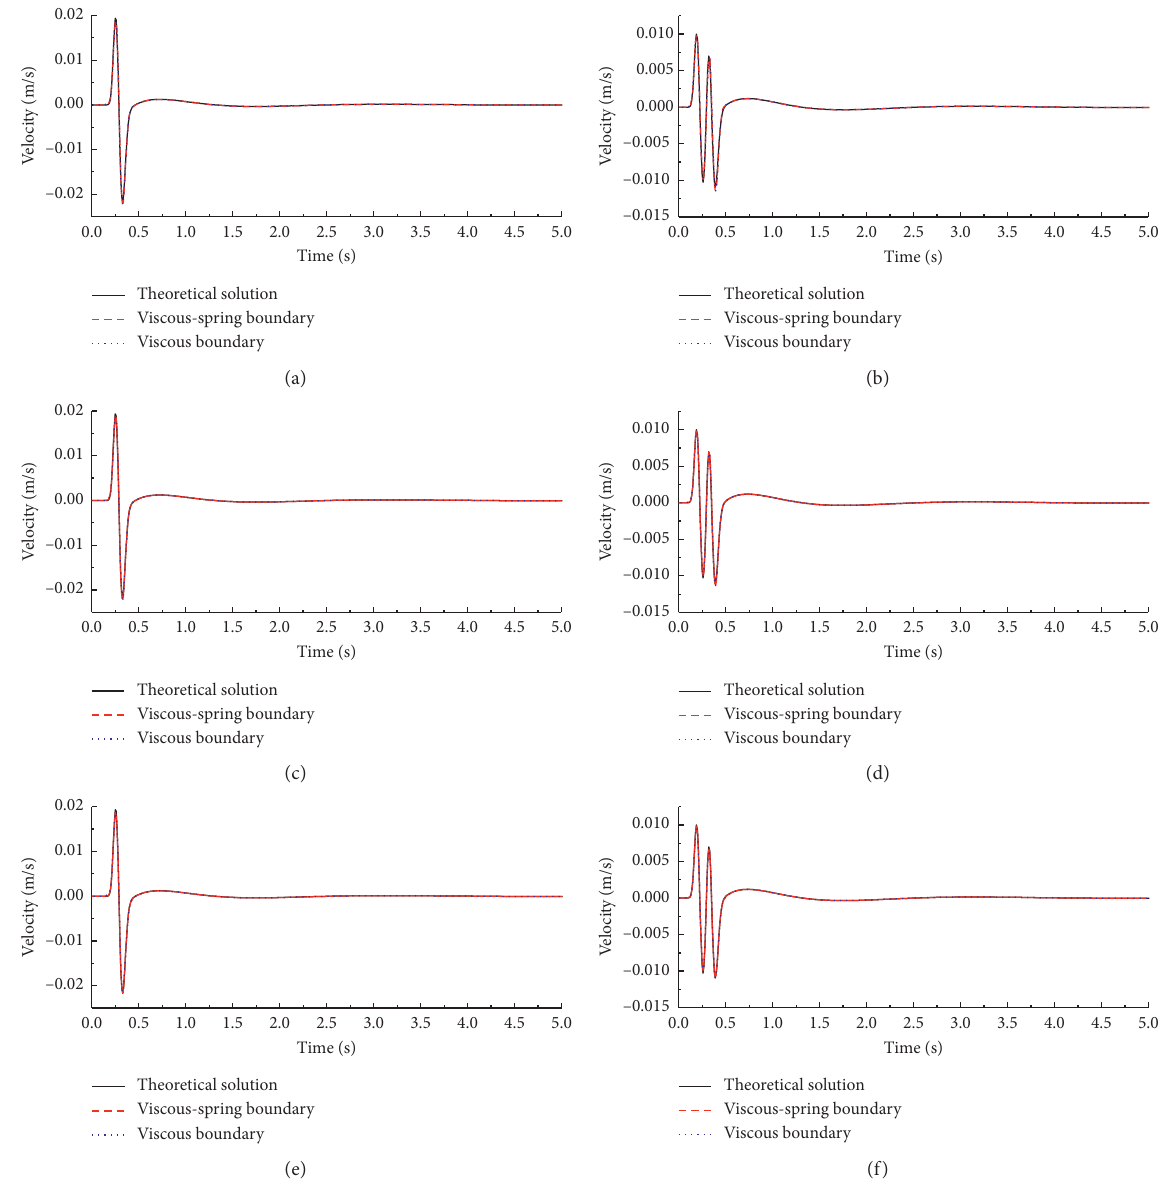
Figure 4: Comparisons between the numerical and theoretical solutions. (a) Horizontal velocity at point a for SV-wave. (b) Horizontal velocity at point b for SV-wave. (c) Horizontal velocity at point c for SV-wave. (d) Horizontal velocity at point d for SV-wave. (e) Horizontal velocity at point e for SV-wave. (f) Horizontal velocity at point f for